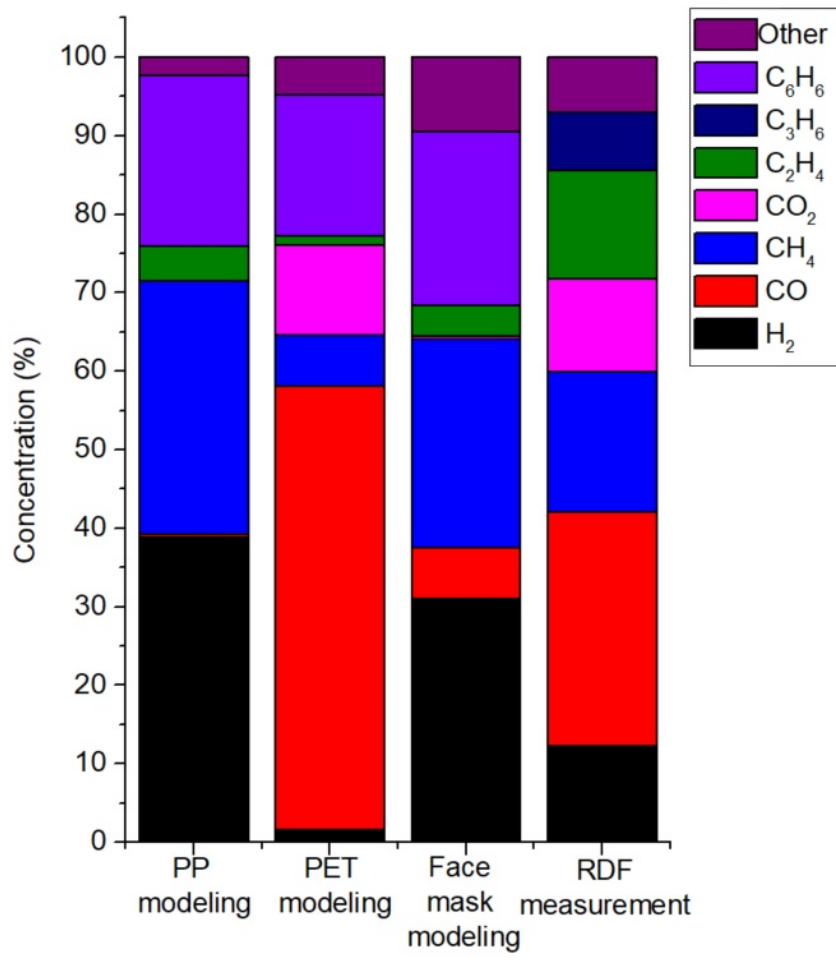
Figure 9. Comparison of selected gaseous pyrolysis products.